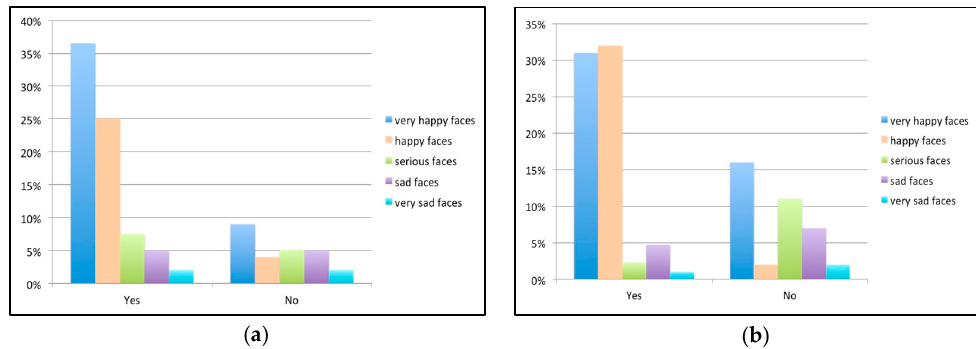
Figure 5. ( a ) Bar chart of the results referring to the practice of sports; ( b ) results referring to the practicing of team sports.